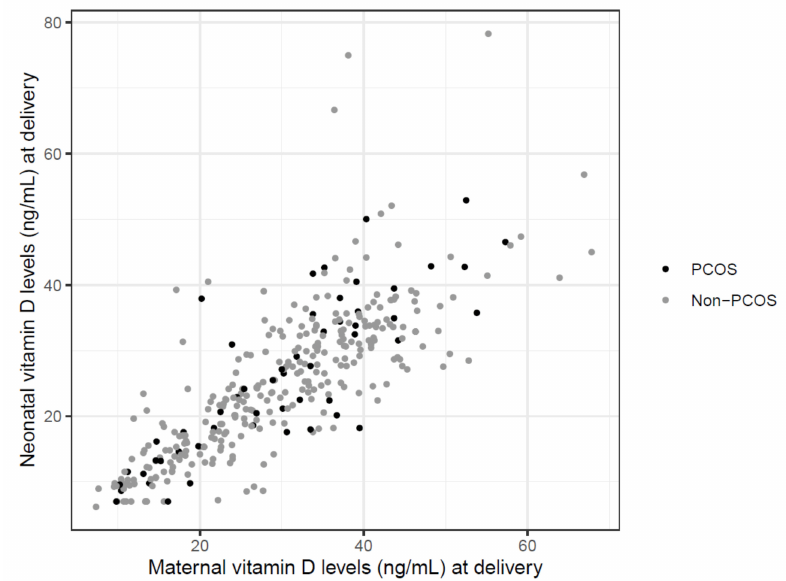
Figure 1. To assess the association between maternal and neonatal 25(OH)D levels, a Pearson correlation analysis and linear regression analysis were performed and a strong correlation between maternal and neonatal 25(OH)D levels in both groups (r ≥ 0.79, p < 0.001) was